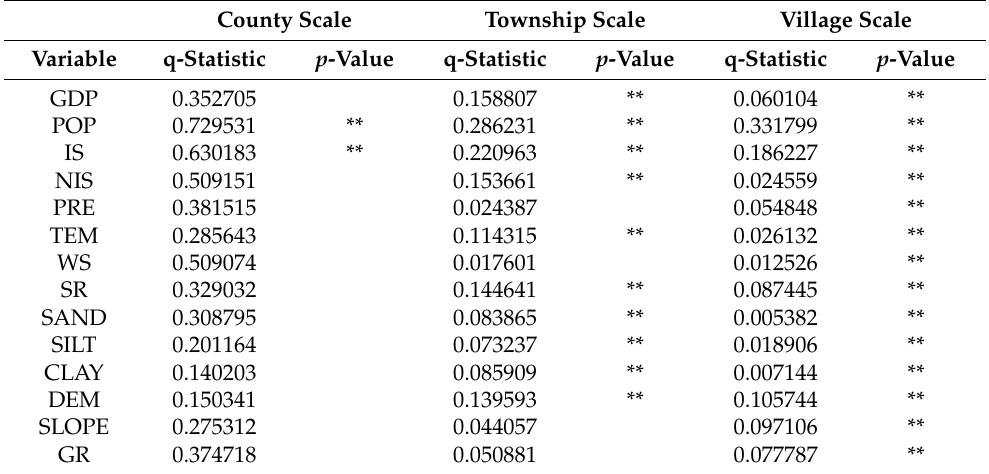
Table 6. Results of factor